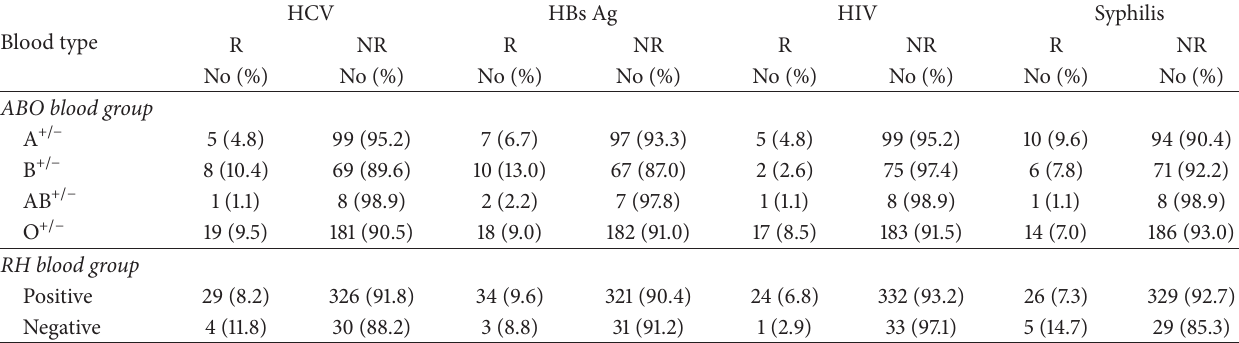
Table 2: Distribution of blood borne pathogens by donor’s blood type among blood donors at Wolaita Sodo Teaching Referral Hospital, 2015. Blood type